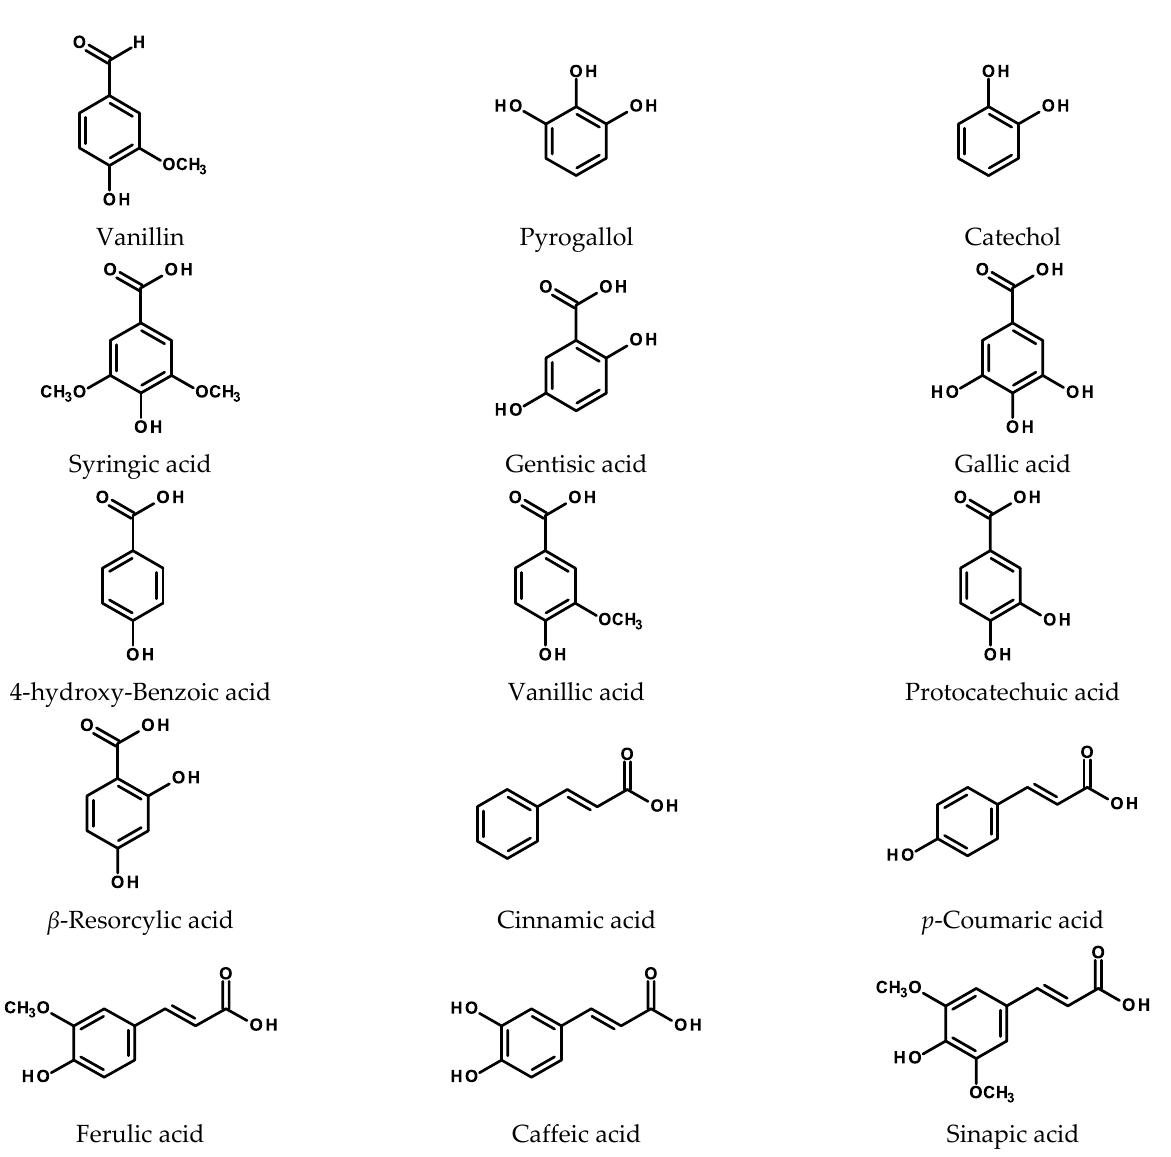
Figure 1. Chemical structures of selected simple phenolics and phenolic acids. Maximum contents of soluble phenolics in the HRs were shown to not usually exceed 0.1% calculated on a dry weight (DW) basis. Cell wall-bound phenolics were present in greater amounts. For example, the cell wall-bounded and soluble form of p -hydroxybenzoic acid ( p -HBA, 4-HBA) constituted up to 0.44% and up to 0.04% DW, respectively, in HRs of Daucus carota L. (Apiaceae) elicited with chitosan [31]. The